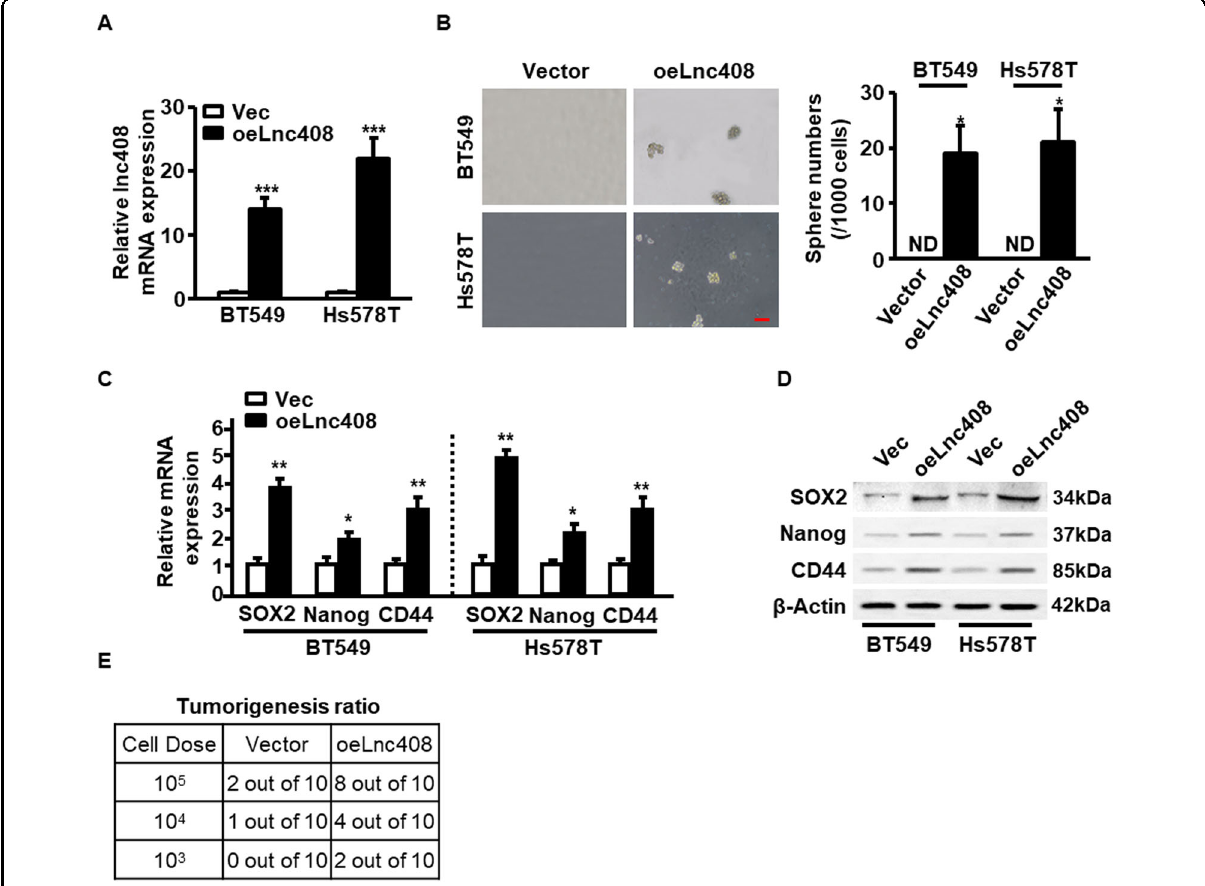
Fig. 3 Lnc408 endow non-CSCs to acquire stemness characteristics in breast cancer. A The expression of ectopic lnc408 was con fi rmed in non- stemness characteristic breast cancer cells (BT549 and Hs578T; *** P < 0.001; Vec control vector, oeLnc408 overexpress of ectopic lnc408). B Lnc408 overexpression endowed non-CSC breast cancer cells with CSC characteristics, checked by mammosphere formation capacity. The right panel represents the statistical results of mammosphere numbers as means ± SD (* P < 0.05; ND none detected; scale bar, 100 μ m). C , D Breast cancer stemness markers (SOX2, Nanog, and CD44) were detected in lnc408-overexpressed cells by qRT-PCR ( C ) and western blotting ( D ) (* P < 0.05, ** P < 0.01). E Non-CSCs transfected with ectopic Lnc408 or control vector were transplanted into mammary fat pads of nude mice in different cell dose (1 × 10 3 – 1 × 10 5 cells/each mouse), tumorigenicity of nude mice was measured during the experimental period (over 3 months; N = 10 for each